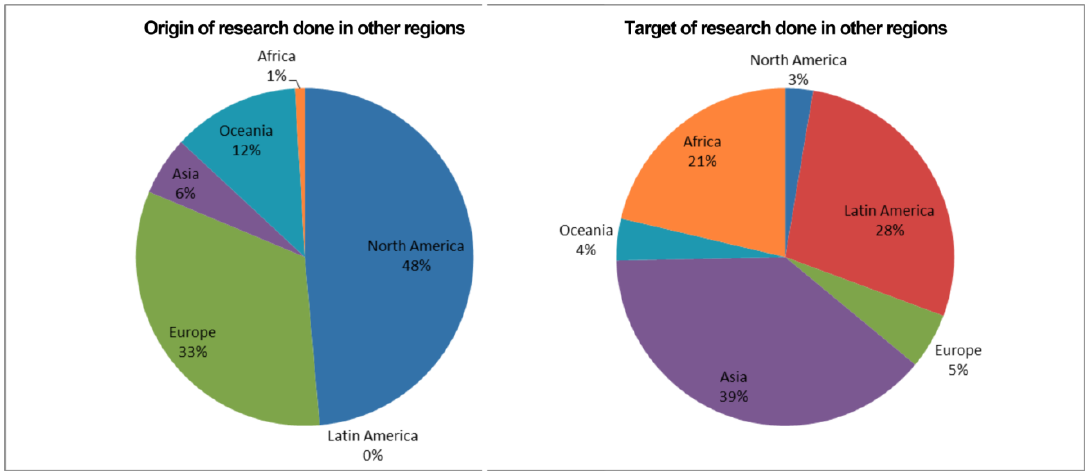
Figure 2. Origin and target of tourism research done in other regions.